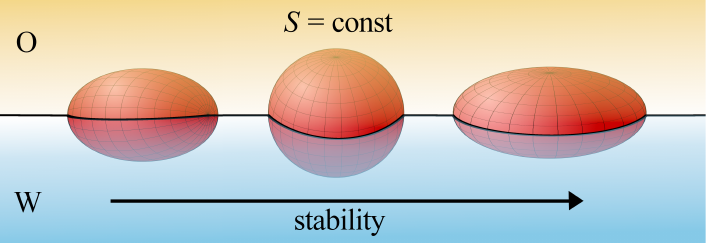
Figure 3. The relative stability of nonspherical nanoparticles at fluid interfaces for particles of different